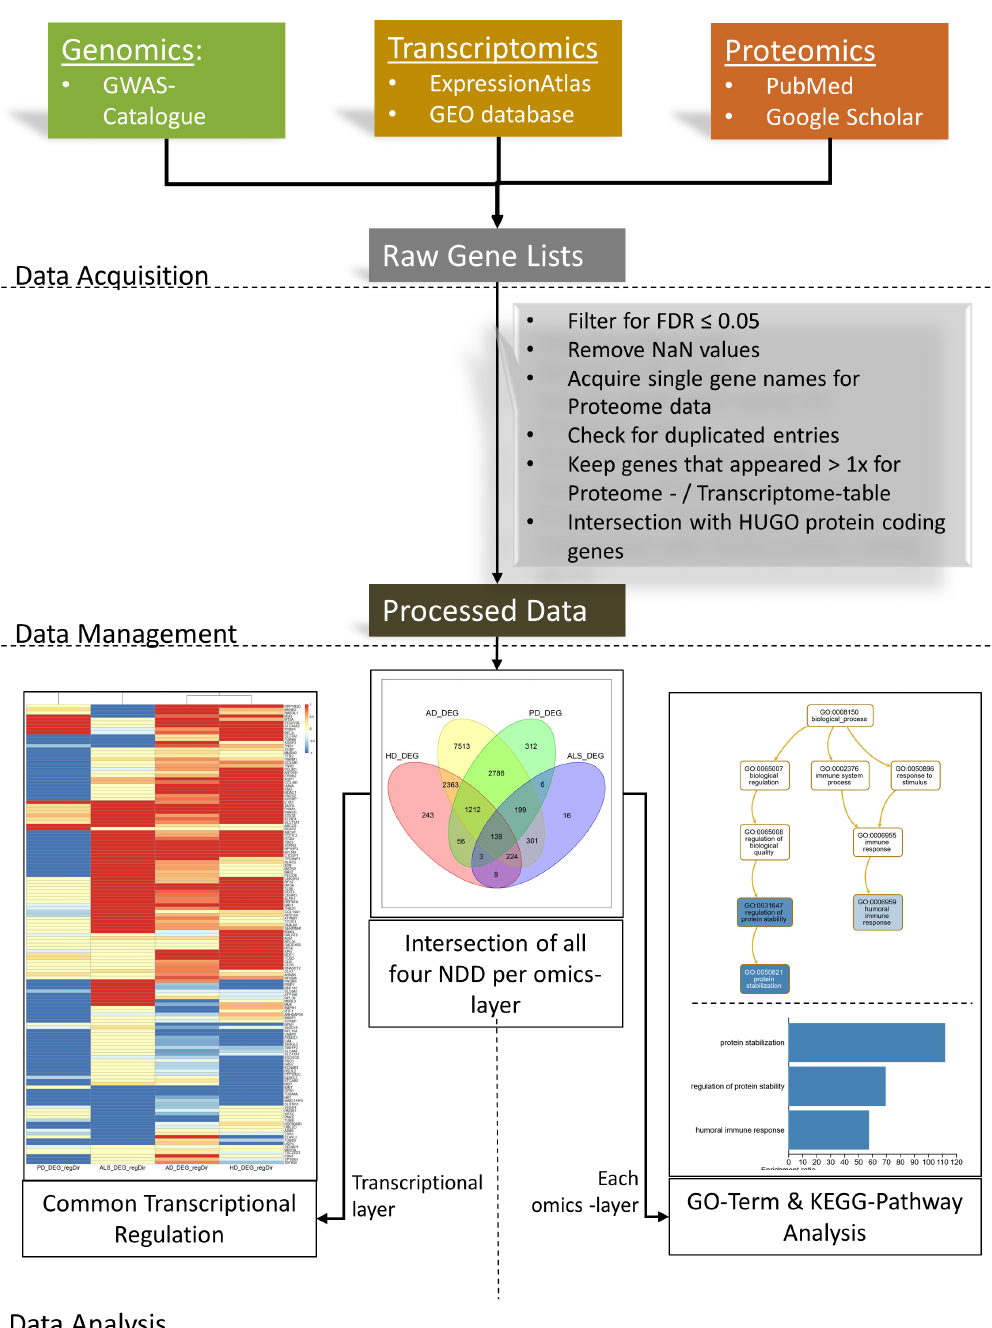
Figure 2. Workflow Overview: Data acquisition was performed using the genome-wide association studies (GWAS) Catalog for genomic data, the European Bioinformatics Institute (EMBL-EBI) Expression Atlas and the Gene Expression Omnibus database for transcriptomic data, and literature research in PubMed and Google Scholar for proteomic data. After filtering these raw data tables and applying some data transformation, the processed data were used for the data analysis. For every omics layer, the intersections of all four analyzed NDDs were visualized as Venn diagrams. Common transcriptional patterns were searched with a hierarchical clustering approach and visualized as a heatmap showing the mean transcriptional direction of regulation per gene, and a dendrogram showing the clustering results. Finally, each set of genes after the intersections was used for the Kyoto Encyclopedia for Genes and Genomes (KEGG) pathway and GO-Term analyses.